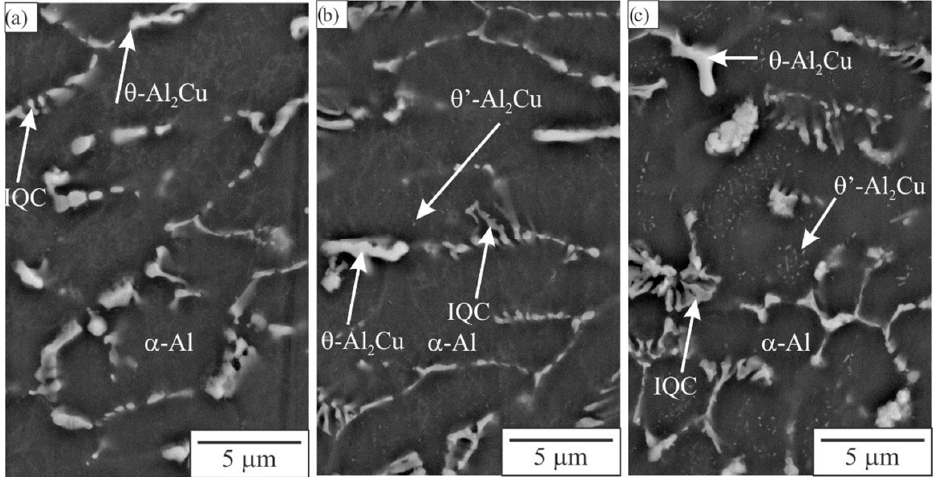
Figure 16. Microstructures in the heat affected zone (HAZ) at different distances from the stir zone at the advancing side of sample FSP950: ( a ) 2 mm, ( b ) 3 mm, and ( c ) 4 mm.